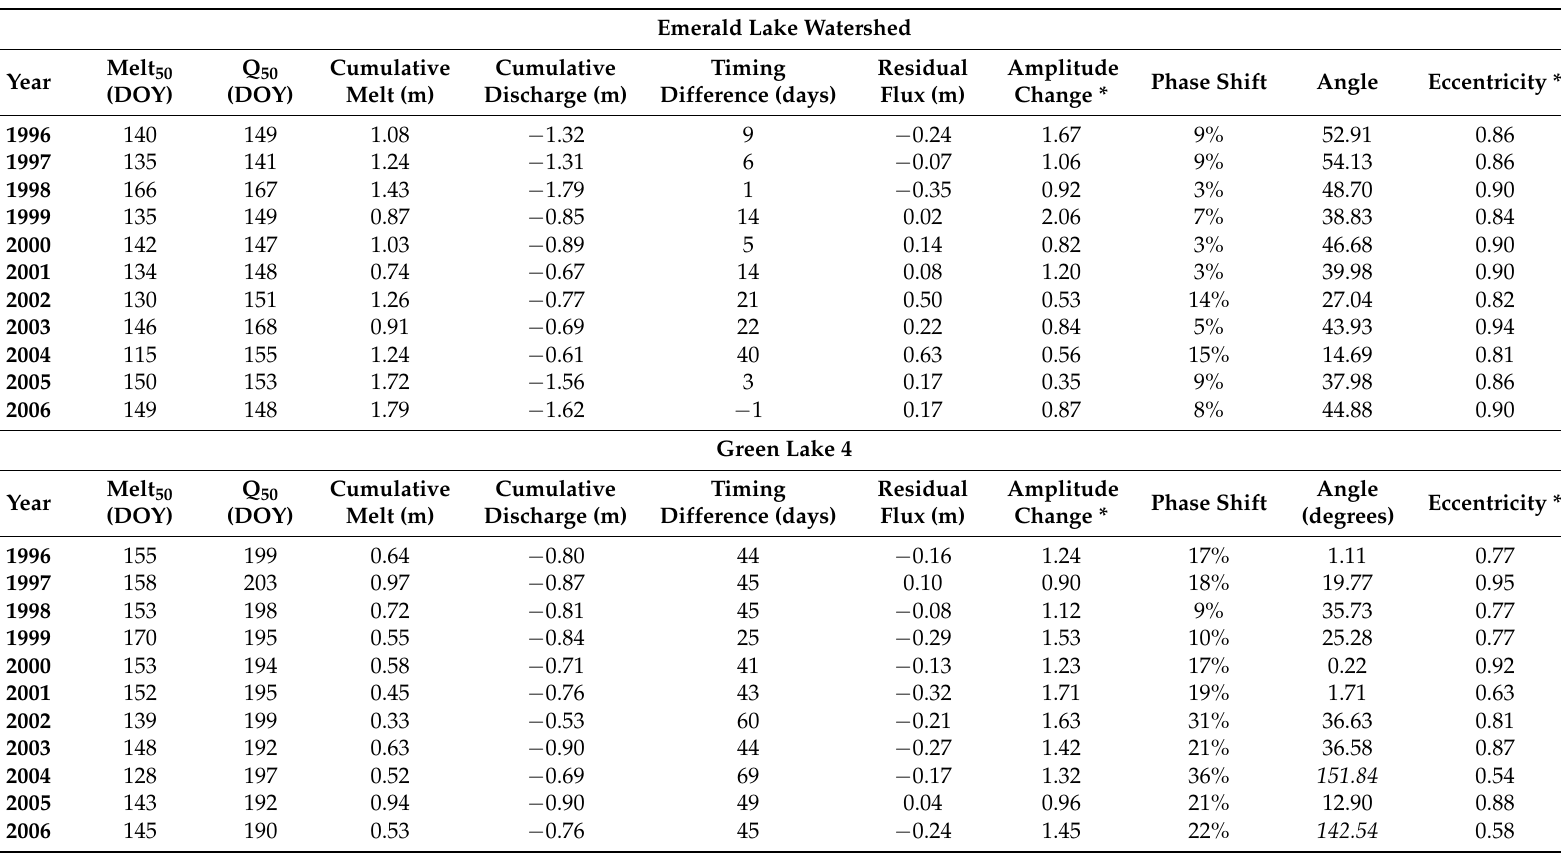
Table 1. Individual snowmelt event and response values for Emerald Lake Watershed (upper) and Green Lake 4 (lower), including event-response ellipse metrics of angle and